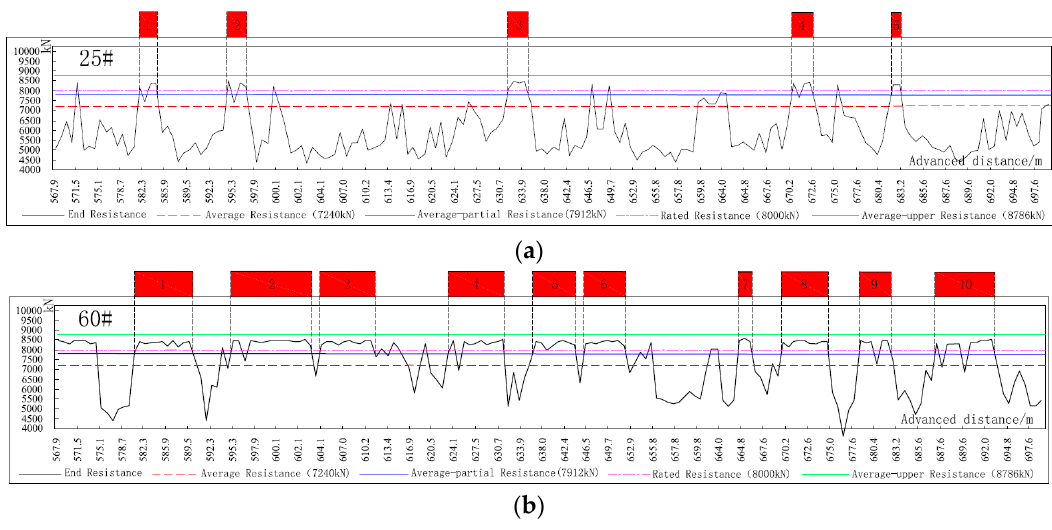
Figure 3. Five kinds of working resistance equation of ( a ) No. 25 and ( b ) No. 60 support.